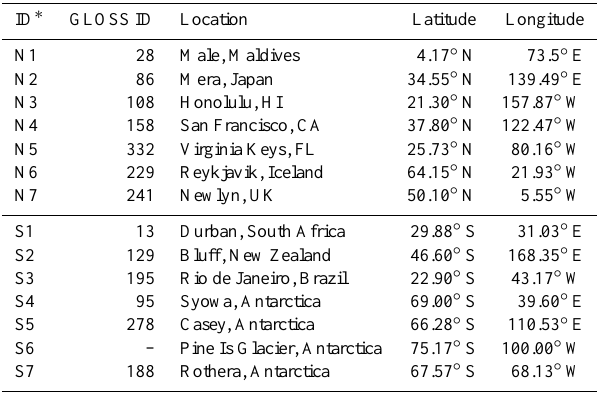
Table 3. Location of selected tide gauge stations, with Global Sea Level Observing System (GLOSS)